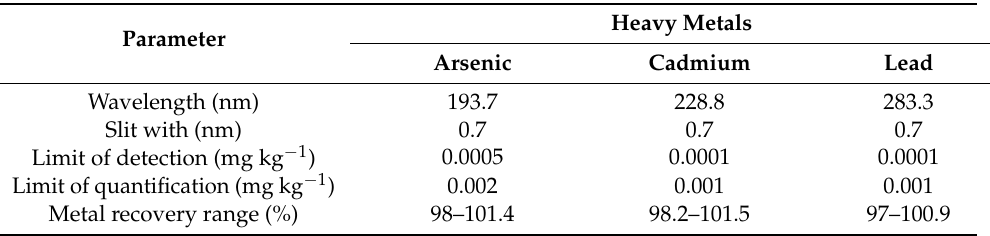
Table 1. Operational parameters used for quantification of arsenic, cadmium and lead in edible tissues of goats slaughtered for human consumption in Enugu State, Nigeria.